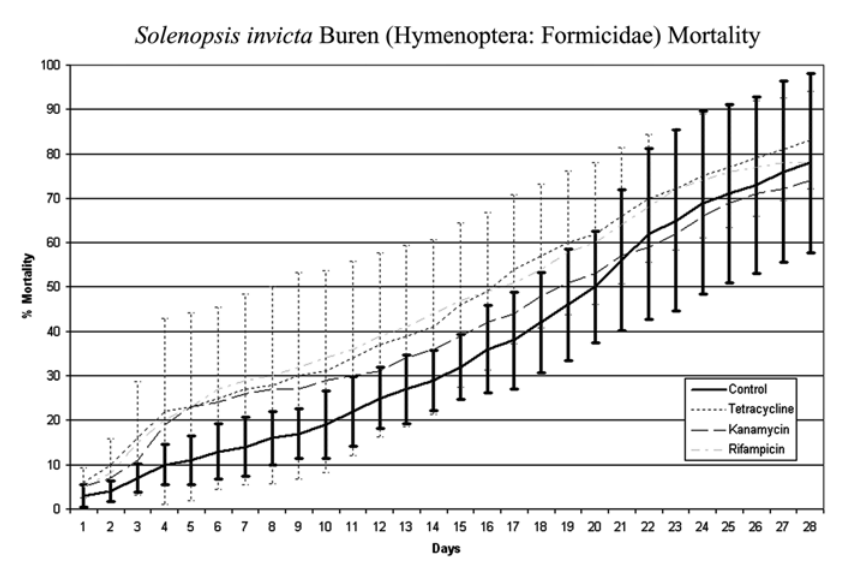
Fig. 3. Mortality curve of untreated and treated S. invicta.